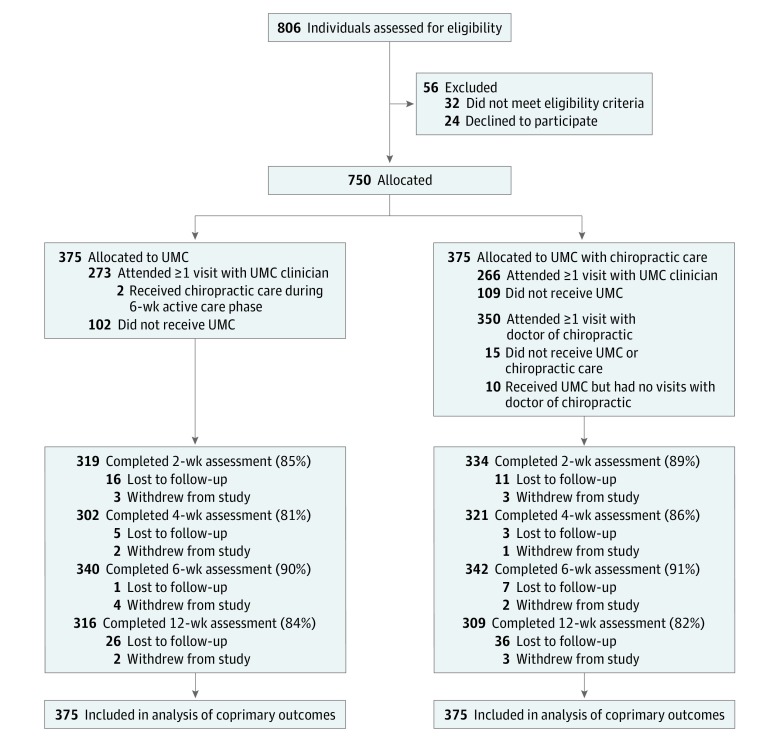
Trial Flow DiagramUMC indicates usual medical care.